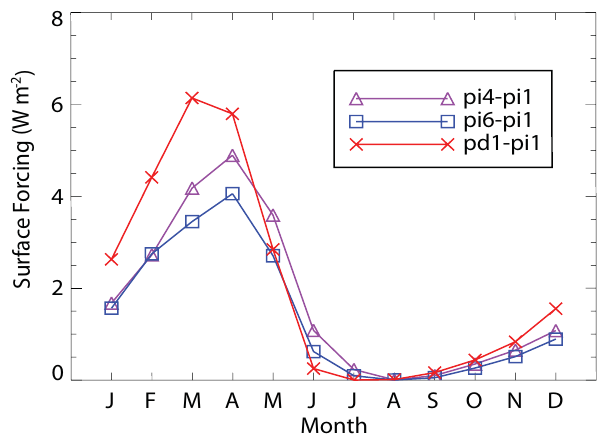
Fig. 7. Monthly surface forcing induced by BC or BC+Dust in snow over Tibetan Plateau (pi4-pi1, pi6-pi1,